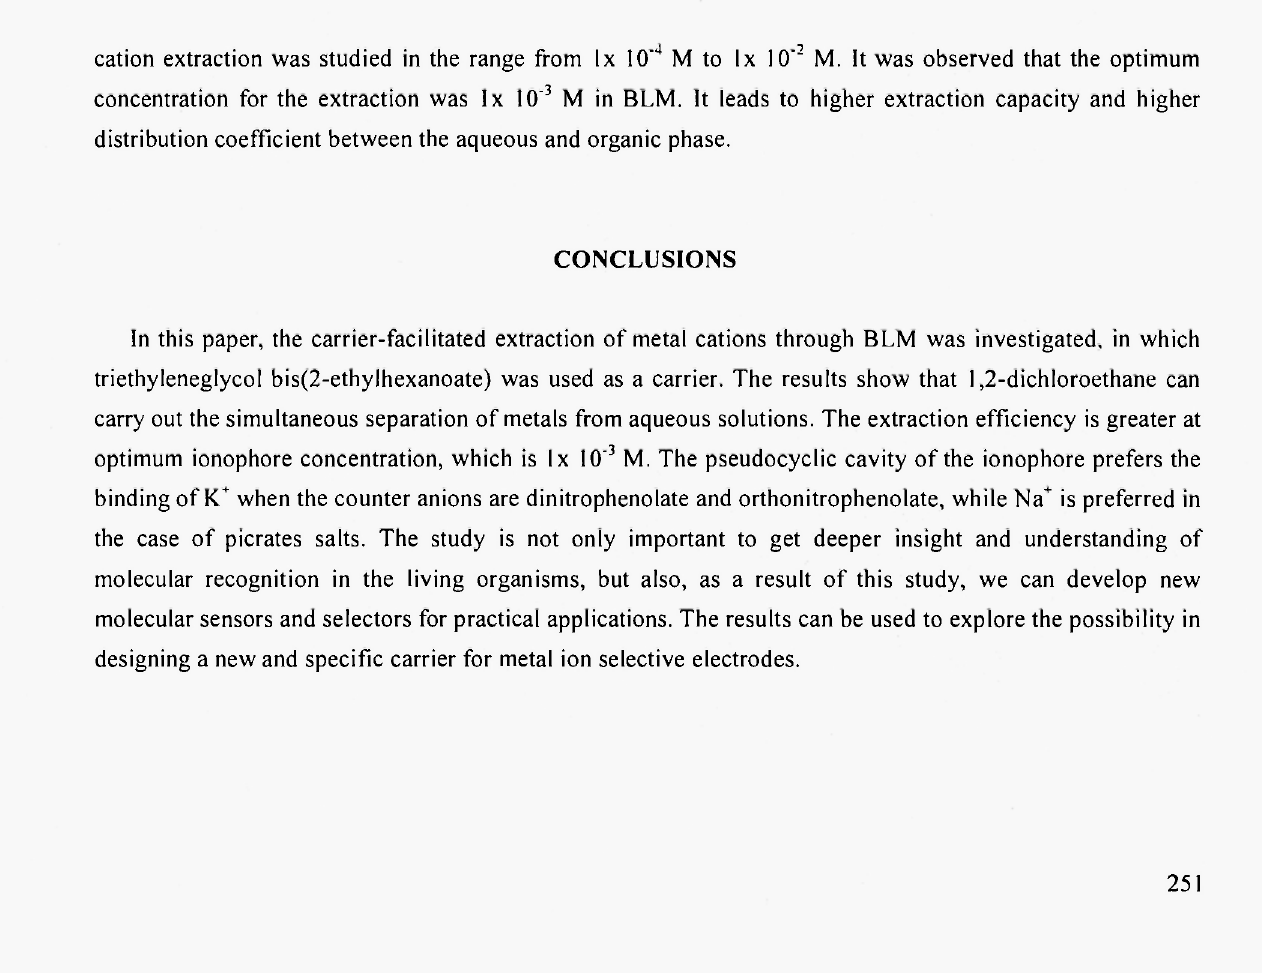
Fig. 7: Distribution ratio of metal ions (Li\ Na + and K. 1 ) in between aqueous (metal salt) phase and organic phase (carbontetrachloride) using Triethyleneglycol bis(2-ethylhexanoate) after 4 hrs.; Aqueous phase (50) ml of metal salt solution (conc" = lx ΙΟ" 3 M); Organic phase (50